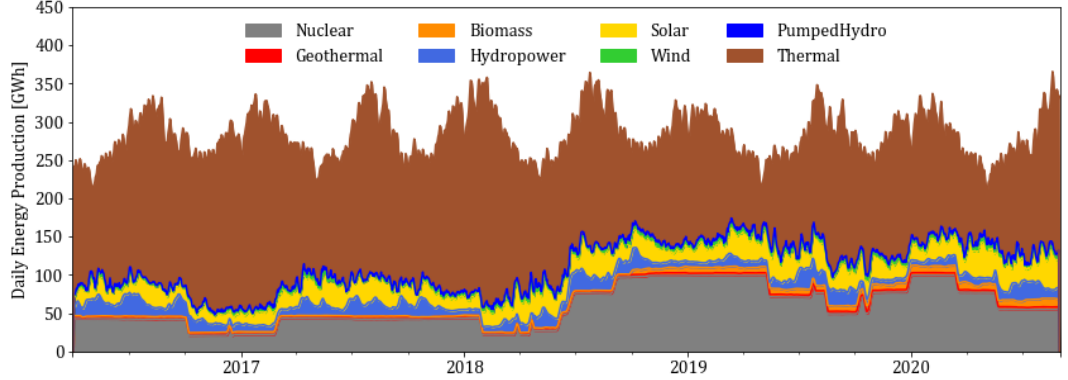
Figure 1. Energy Production of Kyushu Published by Kyushu Electric Power Company.